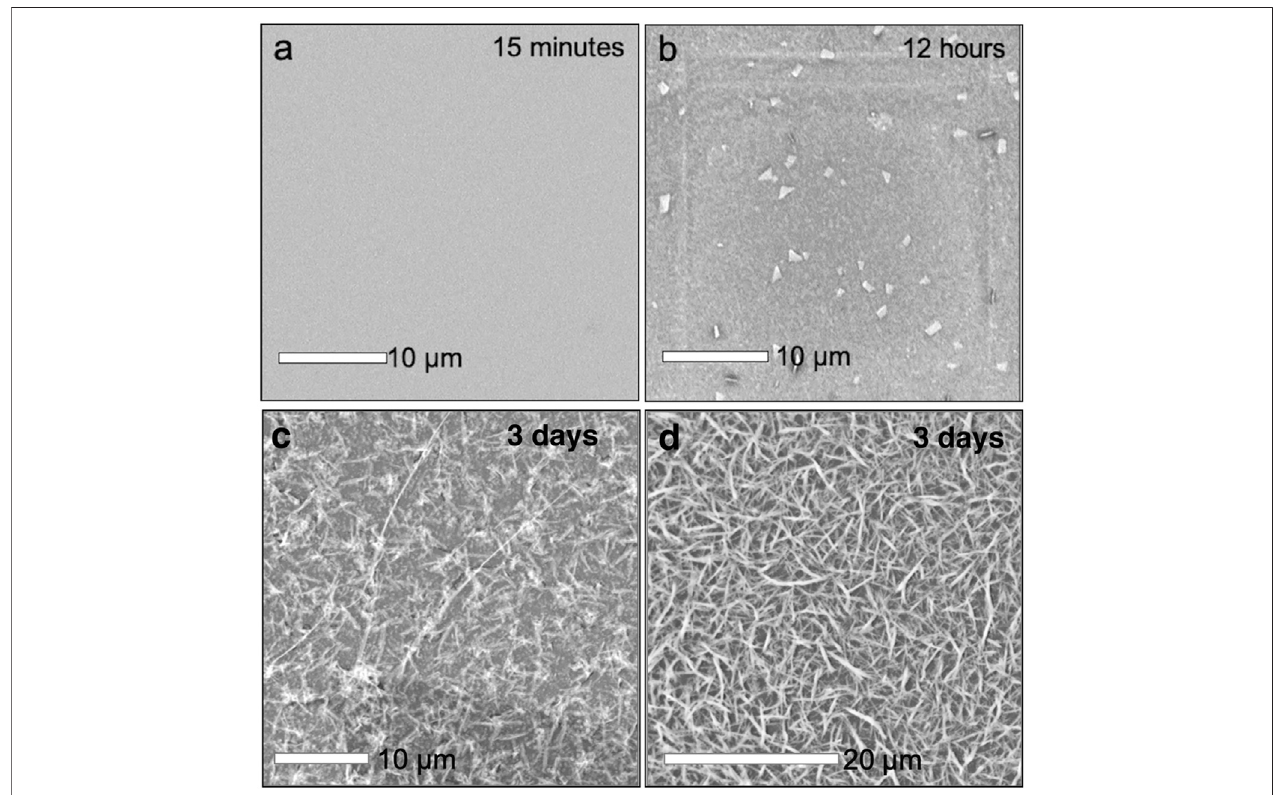
FIGURE 4 | (A) – (D) Scanning electron micrographs of early stage mithrene synthesis, where at 15 min of growth, samples that were dropcasted onto substrate show no presence of mithrene or polymer product. At 12 h of growth, there are immature crystals present, a result of the quenching the reaction and subsequent dropcasting. In comparison is the cold synthesis, where at three days of incubation at 5 ° C, there is no mithrene presence and a thick coating of the amorphous polymer product.